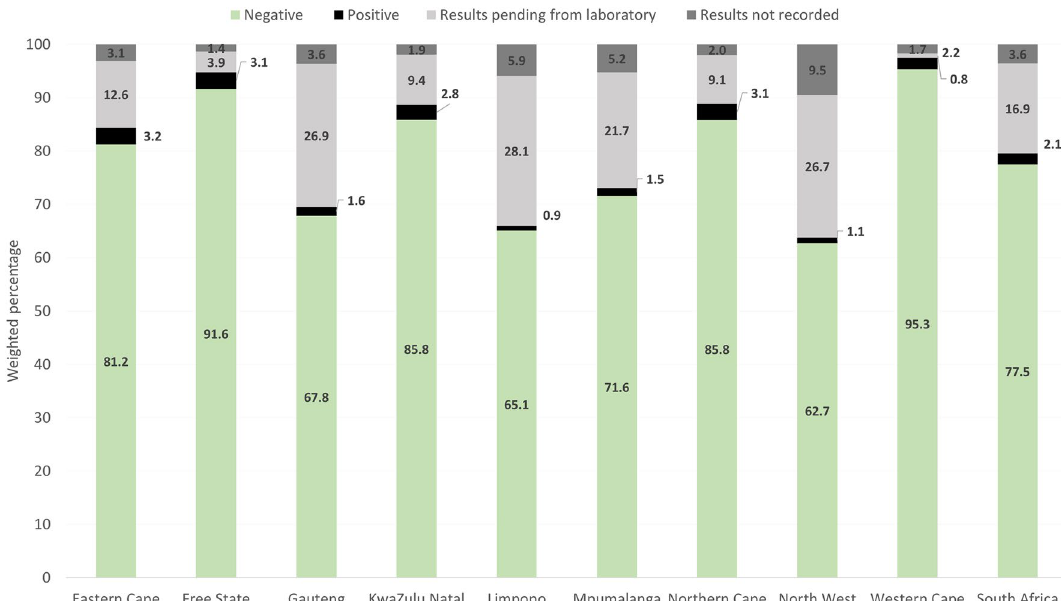
Figure 3. Distribution of syphilis results among pregnant women enrolled in the 2019 ANC sentinel survey by province, N = 34